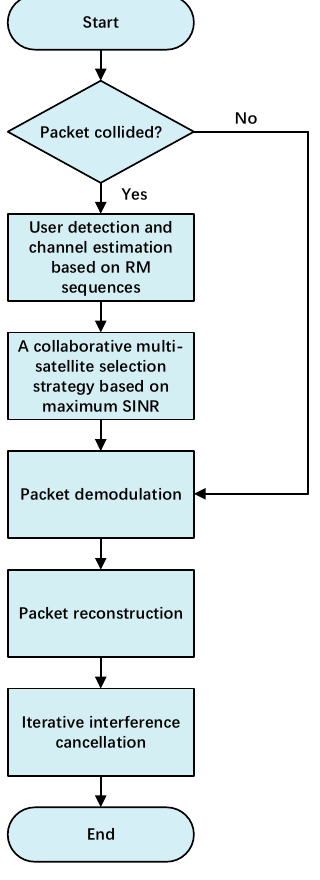
Figure 4. Basic flowchart of the SC-ACRDA scheme.